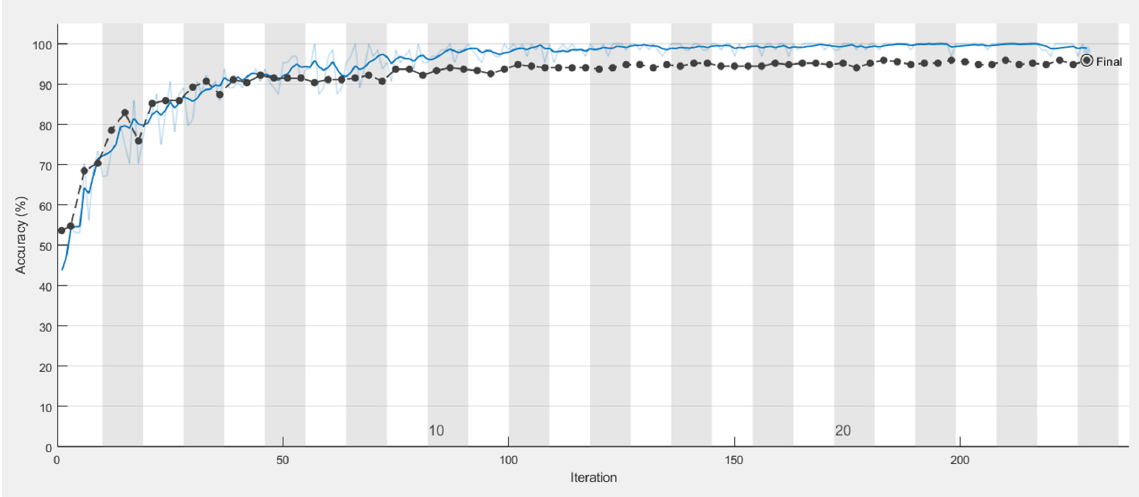
Figure 13. Training process of the model in classifying restorations, with the black and blue lines illustrating the accuracy of the test set and training set, respectively.